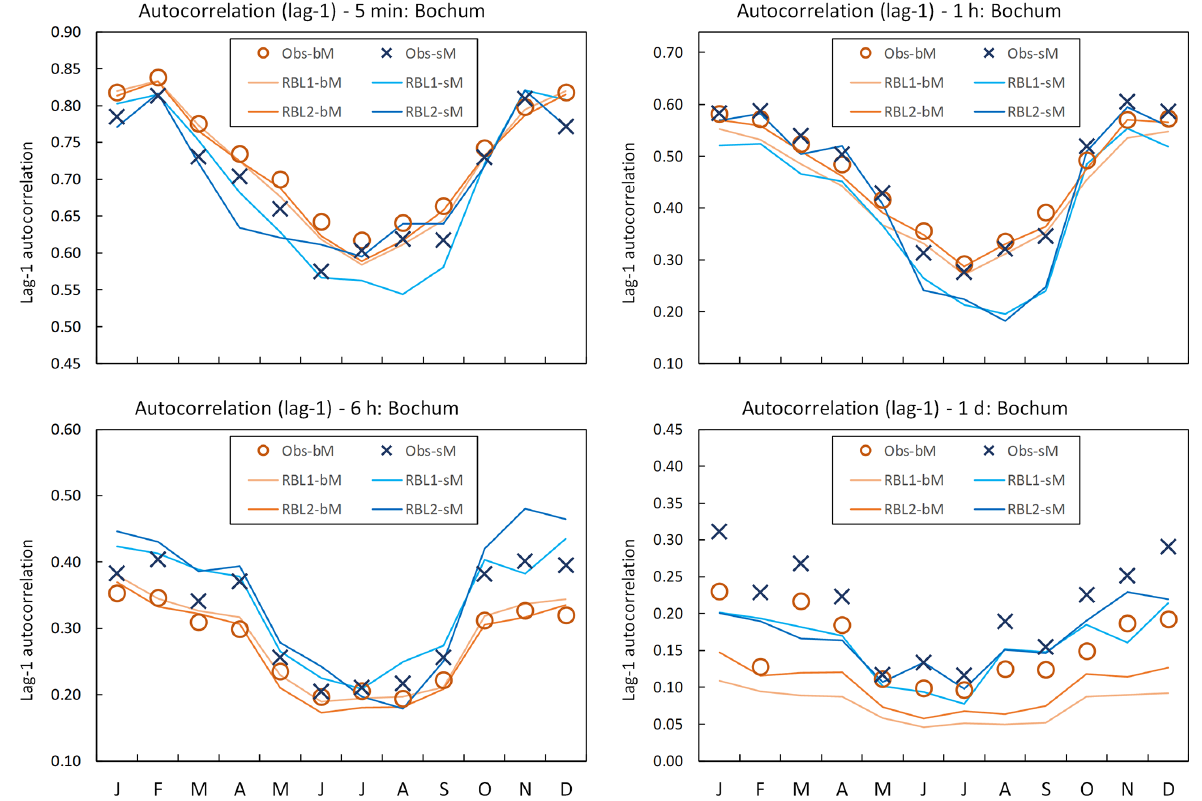
Figure 5. Lag-1 autocorrelation by month at Bochum: the observed lag-1 autocorrelation calculated with block (Obs-bM, orange circle markers) vs. standard (Obs-sM, blue cross markers) methods, the same with the RBL1 (RBL1-bM, light orange line; RBL1-sM, light blue line) models and the same with the RBL2 (RBL2-bM, orange lines; RBL2-sM, blue lines)